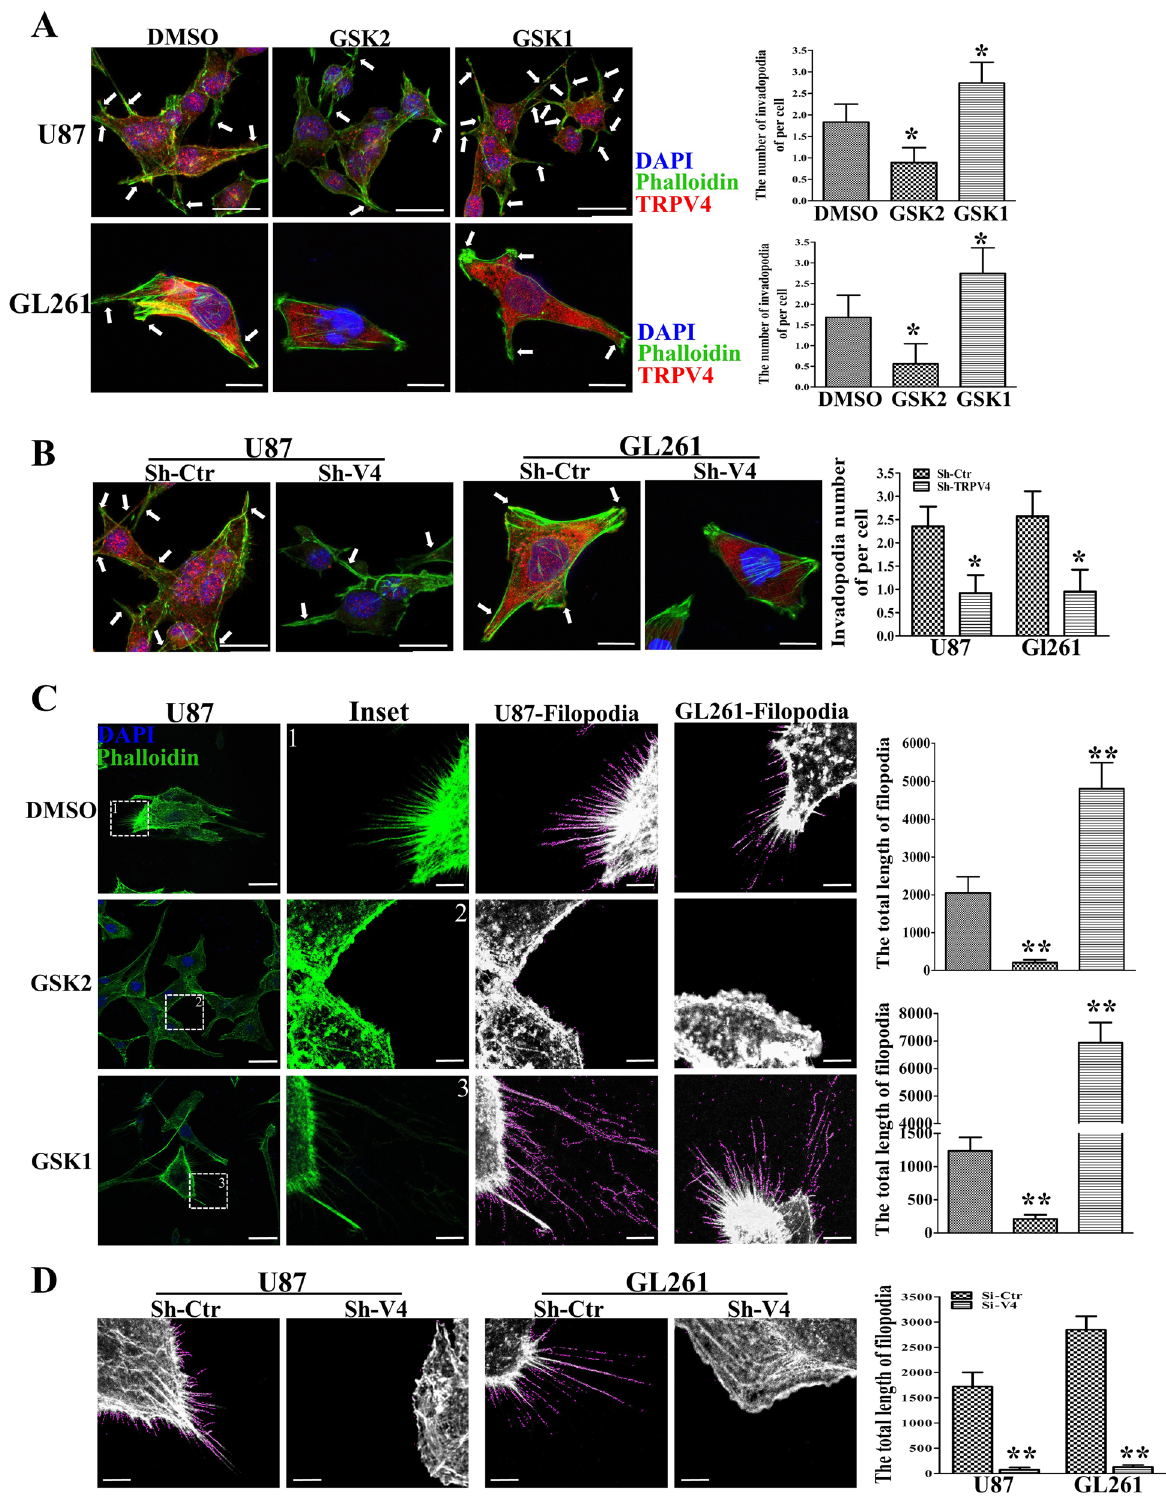
Figure 4. TRPV4 strengthens invadopodia and filopodia formation in glioblastoma cells. ( A ) Representative results of cell morphology and invadopodia were altered by TRPV4 antagonist GSK2193874 (GSK2, 100 nM) or TRPV4 agonist GSK1016790A (GSK1, 10 nM) treatment in U87 and GL261 cells. Histogram showing the number of invadopodia per cell, scale bar = 20 µm and 10 µm, respectively. ( B )The cell morphology and invadopodia were changed after down-regulation of TRPV4 in U87 and GL261 cells, scale bar = 20 µm and 10 µm, respectively. ( C ) IF shows filopodia changes after U87 and GL261 cells were treated with TRPV4 antagonist or agonist, Scale bar = 20 µm. The inset images were analyzed by Fiji software, Filopodia are shown with violet line, Scale bar = 4 µm. The total length of filopodia were calculated and shown by the histogram. ( D )The filopodia was altered by TRPV4 down- regulation in U87 and GL261 cells. Histograms showing the total length of filopodia. The Fluorescent images were exported by Zen software and analyzed filopodia by Fiji software. Scale bar = 4 µm. * p < 0.05, ** p <